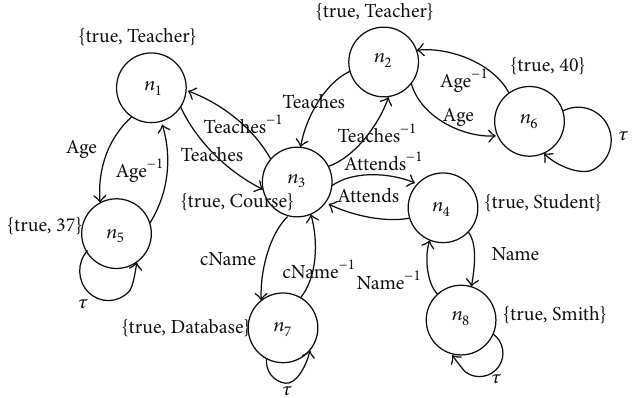
Figure 7: The Kripke structure of Figure